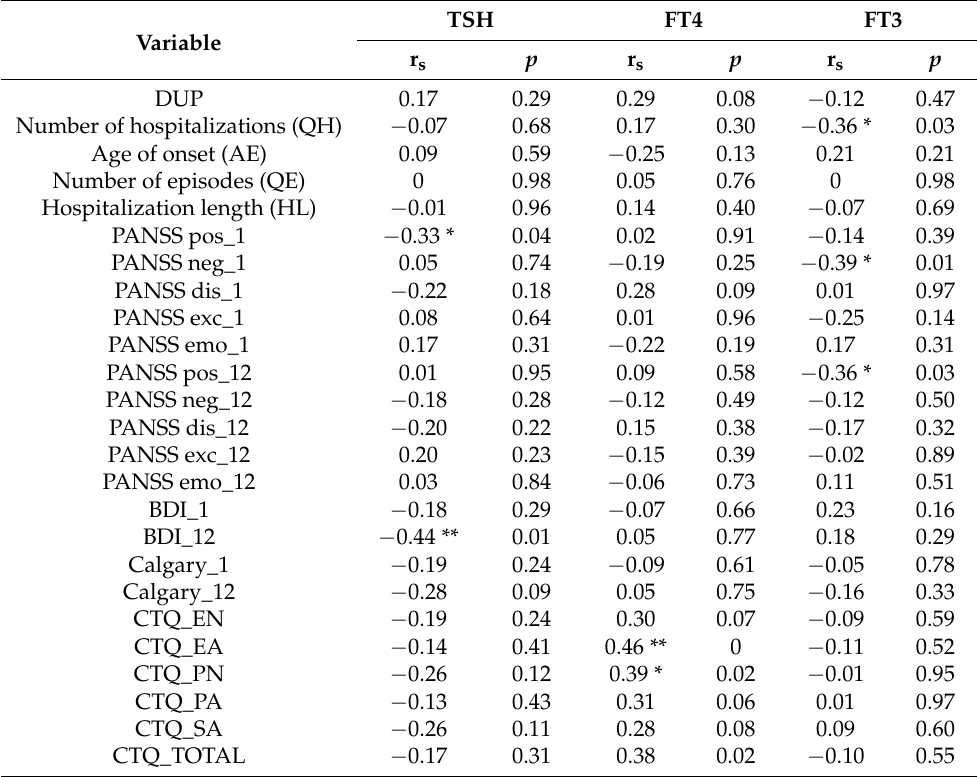
Table 2. Relationship of thyroid parameters with the course of the disease, clinical condition at week 1 and 12 and childhood trauma.